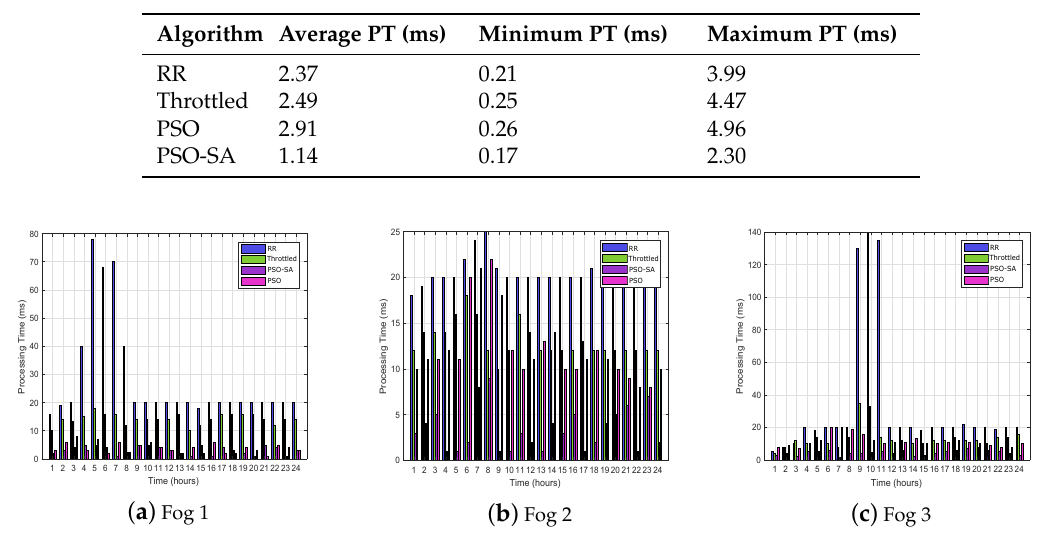
Figure 4. PT of Buildings During 24 h in Scenario